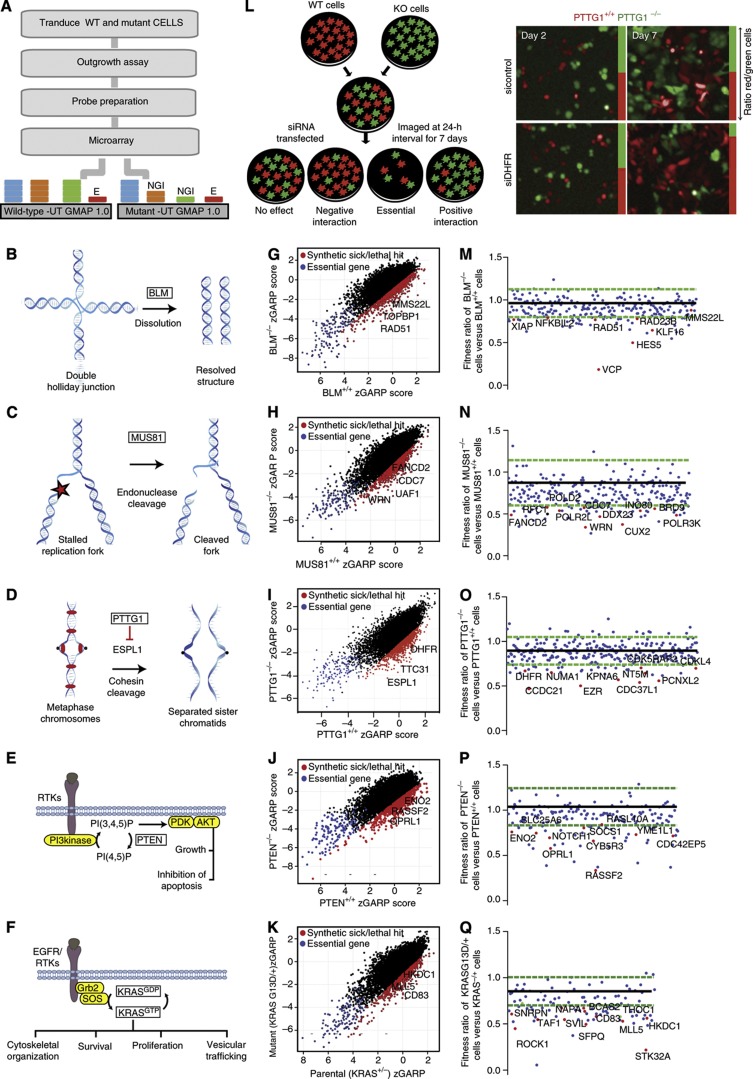
(A) Workflow for the identification of genetic interactions using pooled shRNA screens. E, essential gene; NGI, negative genetic interaction. (B–F) Simplified schematics showing the major functions of the five query genes (boxed in bold) that were screened for negative genetic interactions. (G–K) Scatter plot of zGARP scores for parental and query cell lines from primary screens. Negative genetic interactions (P<0.05) with the query genes are indicated in red, whereas genes that are essential in both parental and mutant lines are highlighted in blue. (L) Experimental setup for the HCS-based co-culture assay and representative images from PTTG1 competition assay at days 2 and 7 for control and DHFR knockdown conditions. The PTTG1+/+ cells are in red and the PTTG1−/− cells are in green. The green and red vertical bars at the side of each image represent the proportion of red/green cells within that image as determined by image analysis. (M–Q) Results from the secondary competition assays for each of the five query genes. The y-axis represents the average fitness ratio of mutant cells versus parental cells (n=2). The black line represents the mean of the lowest drop from mock-transfected cells (n=25). The green dotted lines represent the highest and lowest distribution of the mock-transfected cells with 80% CI. Red dots are genes that were examined in more detail in tertiary assays.